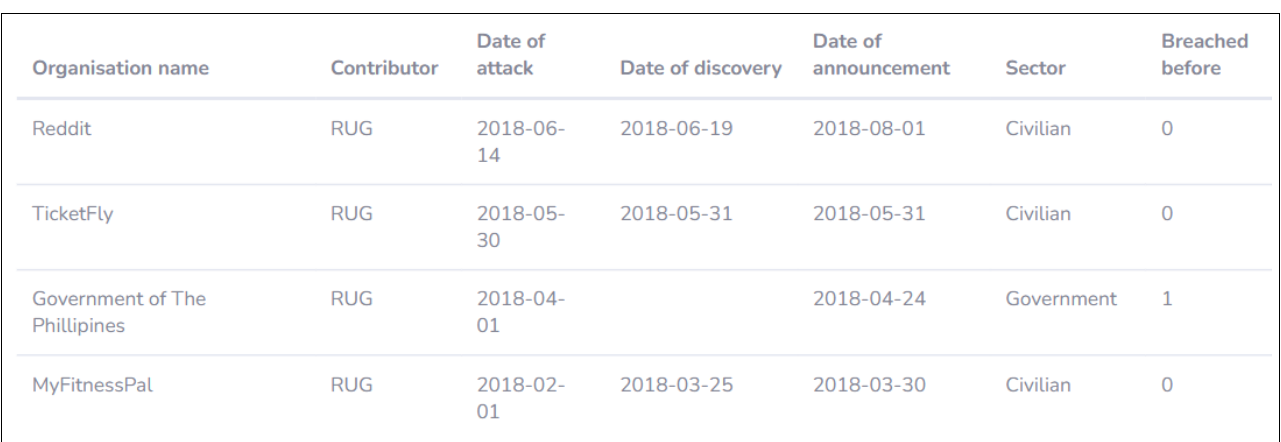
Figure 3. A snippet of the attacks displayed at bottom of the main page. Note that not all columns are shown here.